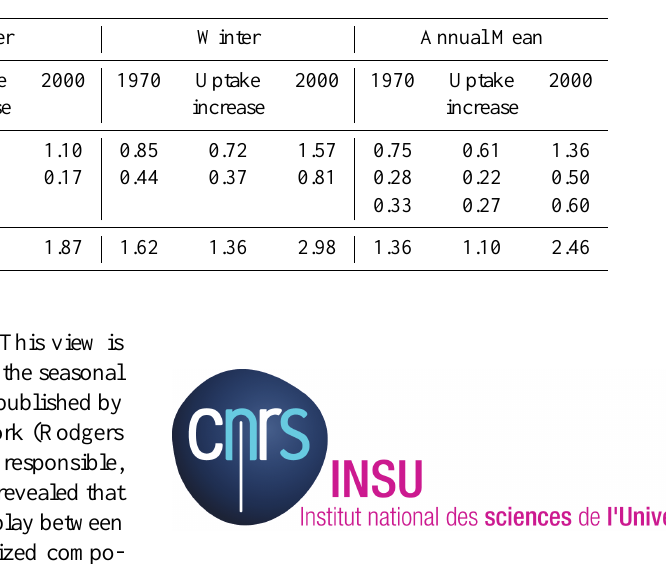
Table 1. Carbon uptake (in PgCyr − 1 ) in 1970 and 2000 for summer, winter and the annual mean. The global carbon uptake for summer (winter) is calculated using the August (February) output north of 20 ◦ N, the February (August) output south of 20 ◦ S and the annual mean outputs between 20 ◦ N and 20 ◦